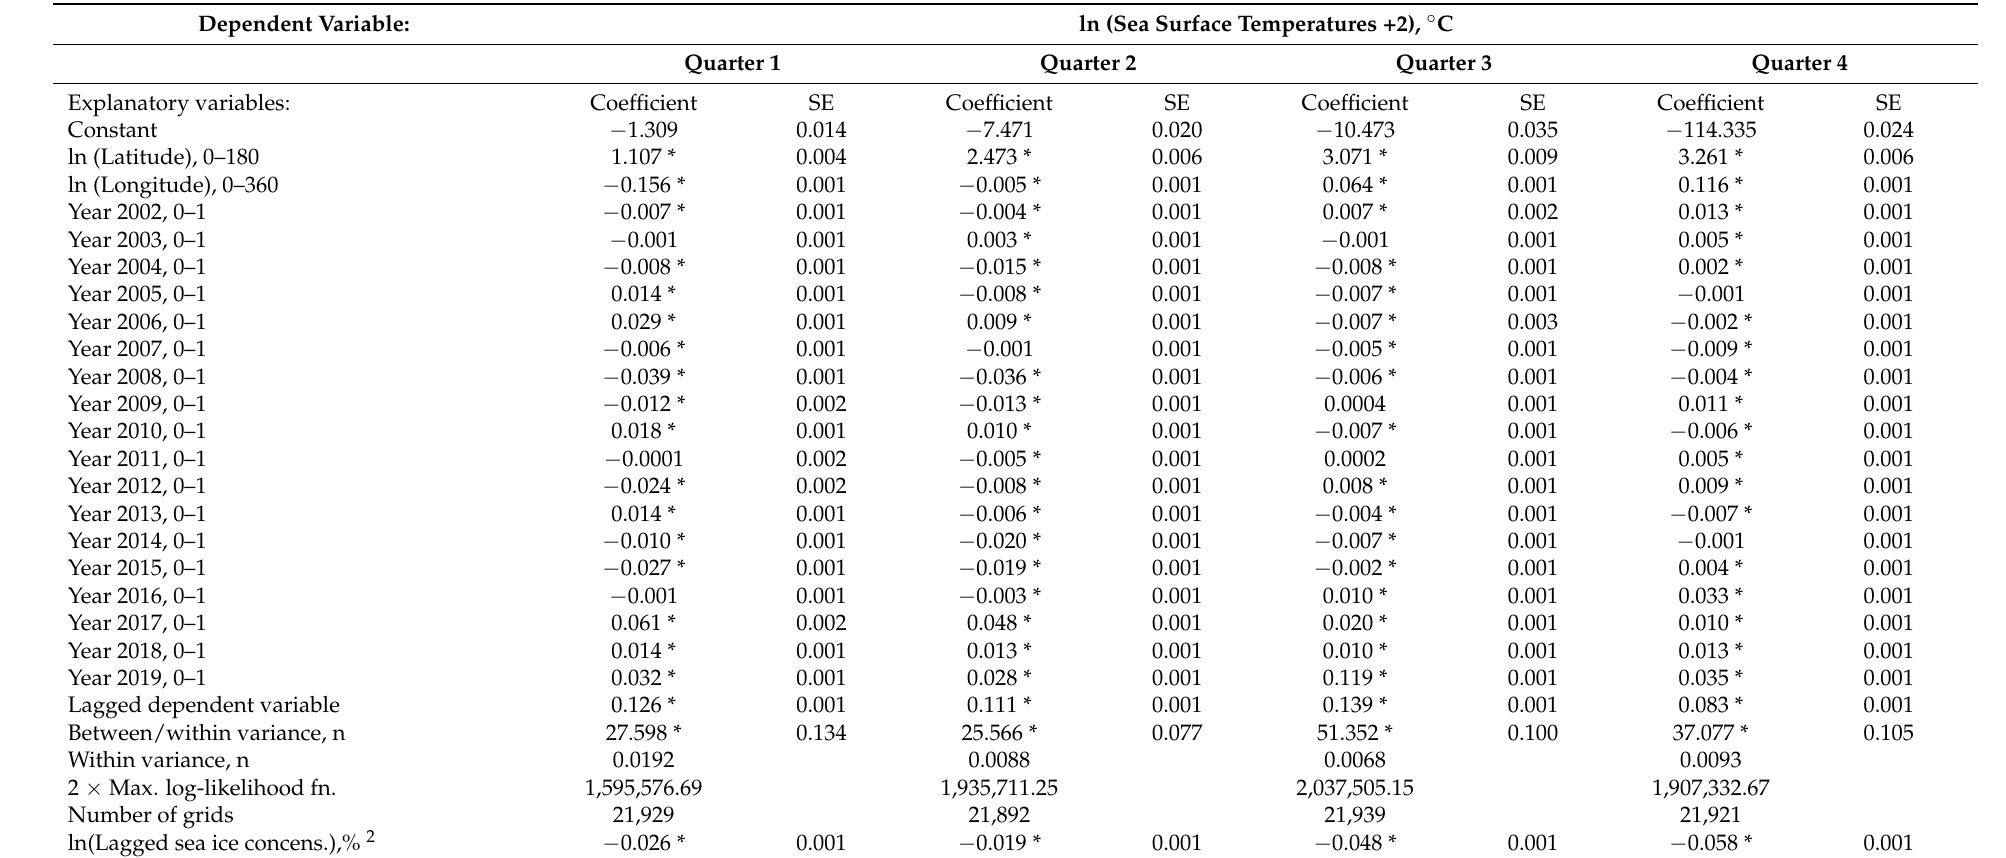
Table 4. Maximum likelihood estimates of dynamic random effects models using quarterly data for 2000–2019 for 1 × 1 degree grids on sea surface temperatures in the Southern hemisphere explained by geodesic variables and time indicators for the years 1